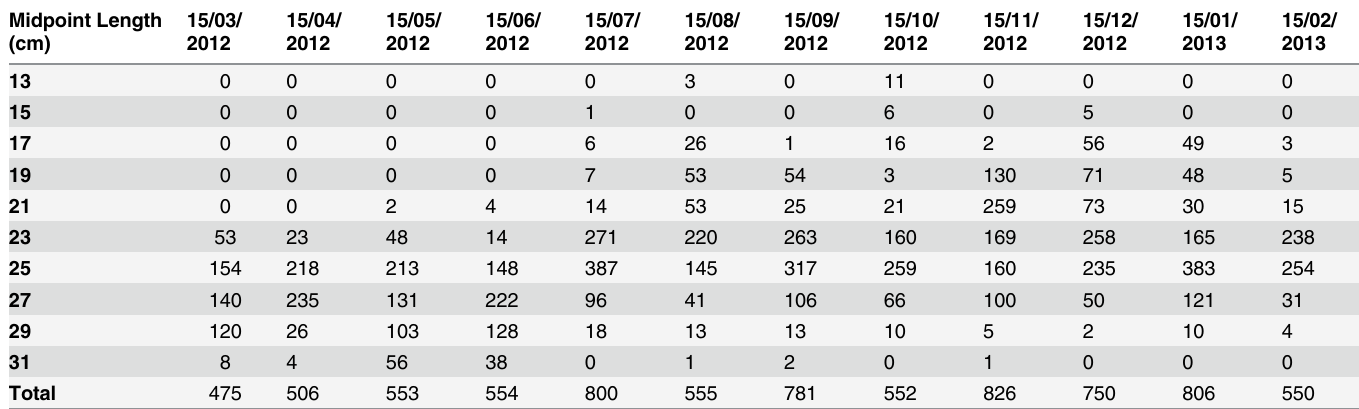
Table 2. Size distribution of Sardinella maderensis specimens (n = 7708) collected in Senegalese waters from March 2012 to February 2013. Midpoint Length